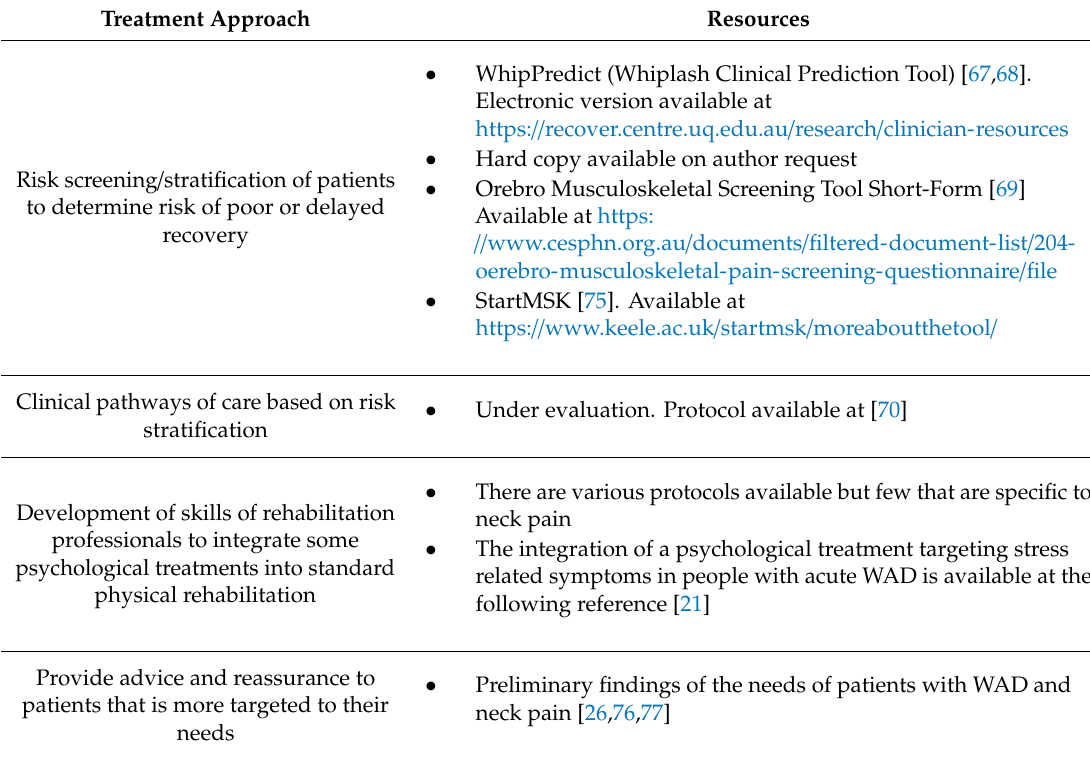
Table 2. Promising directions for clinical